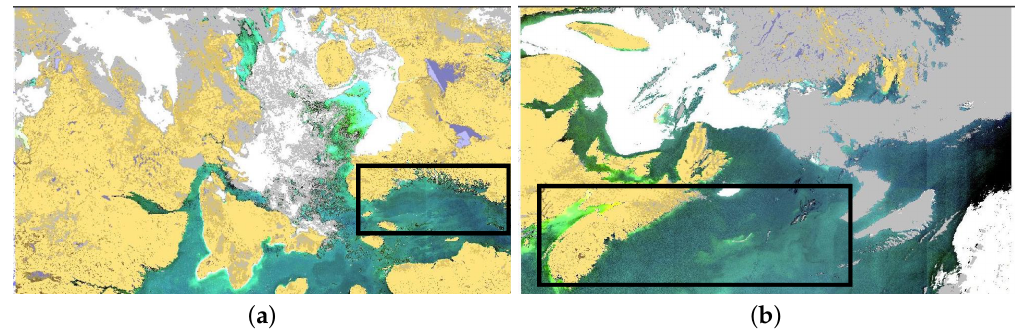
Figure A1. ( a ) RGB image of the Marginal Ice Zone, acquired on the 8th of July 2017 by Sentinel 3 OLCI. ( b ) RGB image of coastal and open oceans acquired at 10 June 2017 by Sentinel 3 OLCI. Masks: land (orange), cloud (gray) and snow-ice (white). The black squares show the selected areas for the enlarged